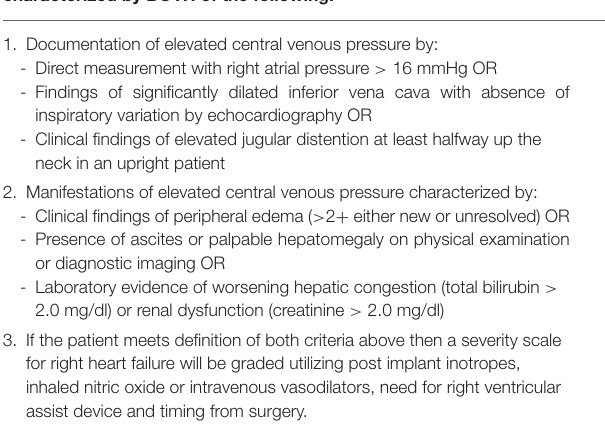
TABLE 2 | 2014 INTERMACS definition for right heart failure. Definition: Symptoms or findings of persistent right heart failure characterized by BOTH of the